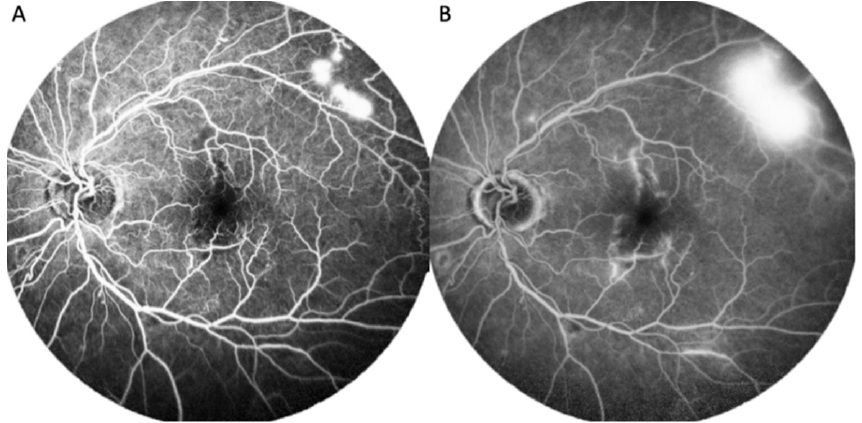
Figure 3. ( A ) Fluorescence stains and leakage at temporal upper; and ( B ) Obvious fluorescence leakage from the temporal upper lesion as well as paramacular neovascular leasions shown at late stage.